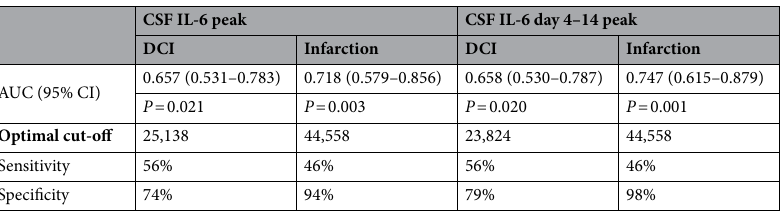
Table 5. Receiver operating characteristics (ROC) analysis. AUC area under the curve, CI confidence interval, CSF cerebrospinal fluid, DCI delayed cerebral